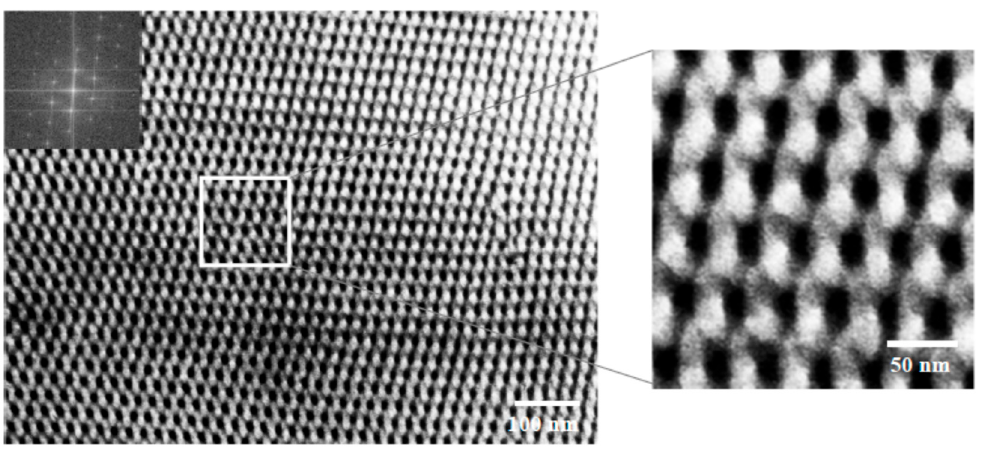
Figure 2. Bright ‐ field TEM image and a “magnified area” for enhancing details, exhibiting approximately a [110] projection. The insert at the upper left of the TEM image is the corresponding FFT (fast Fourier transform). White areas correspond to PS domains, grey areas to 3,4 ‐ PI blocks and the black areas to the PB segments after staining with OsO 4 for approximately 30 min.